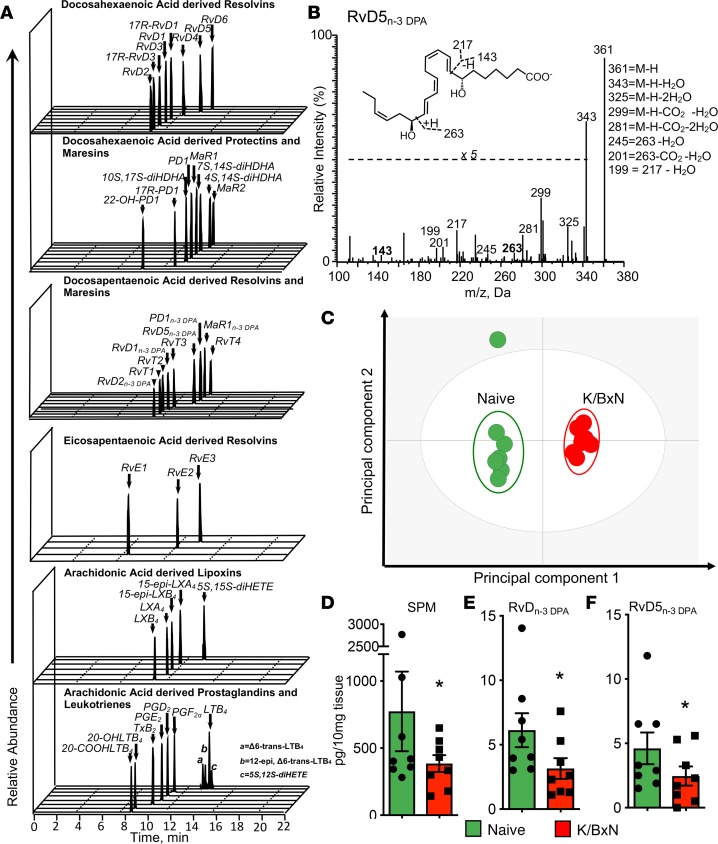
Arthritis dysregulates intestinal lipid mediator profiles.Arthritis was initiated by injection of K/BxN serum (50 μL per mouse, i.p.; days 0 and 2). On day 8 ilea were harvested from arthritic and naive mice and lipid mediators identified and quantified using lipid mediator profiling (see Methods for details). (A) Representative multiple reaction monitoring (MRM) traces for identified lipid mediators. (B) Representative MS/MS spectrum employed for the identification of RvD5n-3 DPA; inset, diagnostic ions; M, molecular mass. (C) Orthogonal partial least squares discriminant analysis (oPLS-DA) of intestinal lipid mediator profiles. Cumulative tissue concentrations for SPMs (i.e., arachidonic-, eicosapentaenoic acid–, n-3 docosapentaenoic– [DPA–], and docosahexaenoic acid–derived [DHA-derived] proresolving mediators) (D), RvDn-3 DPA (i.e., RvD1n-3 DPA, RvD2n-3 DPA, and RvD5n-3 DPA) (E), and RvD5n-3 DPA (F). Results for A and B are representative of n = 24 mice; for C are representative of n = 8 mice per group; for D–F are mean ± SEM for n = 8 mice per group from 2 independent experiments; *P ≤ 0.05 versus naive using Mann-Whitney U test. Results are expressed as pg/10 mg tissue.